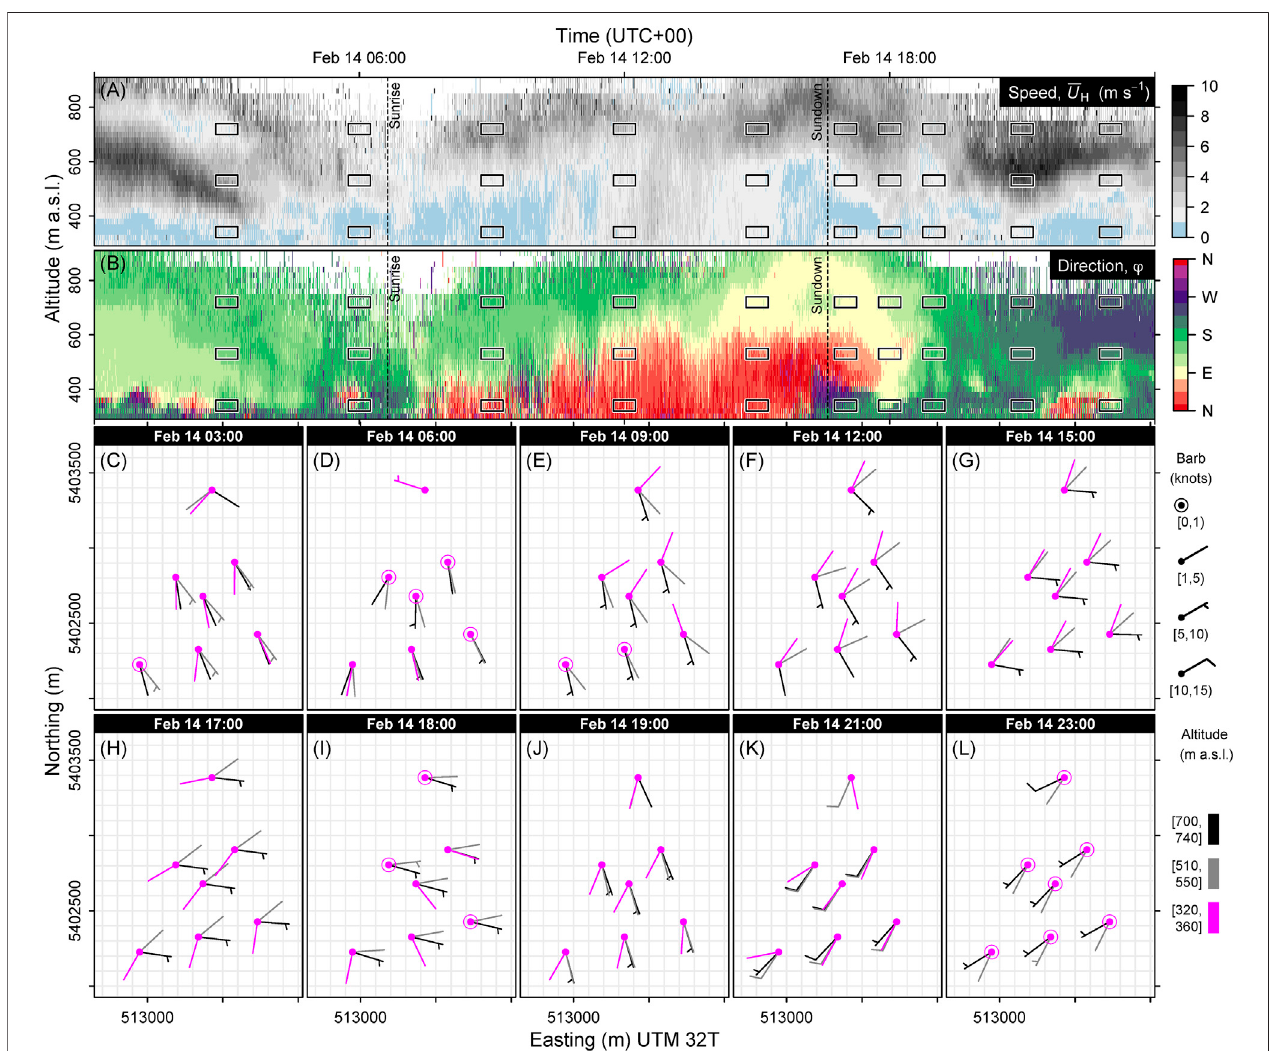
FIGURE7 | For aselected weak-wind day in winter (14 February2017), acompositeofthe vertical pro fi les in Stuttgart CityCentreof (A) the wind direction and (B) thewindspeedareshowntogetherwith (C – L) themeanwind fi eldforselectedlocations,altitudesandperiodsinanareacorrespondingto Figure1D .Thealtitudesand periods are annotated in panels (A,B) by black